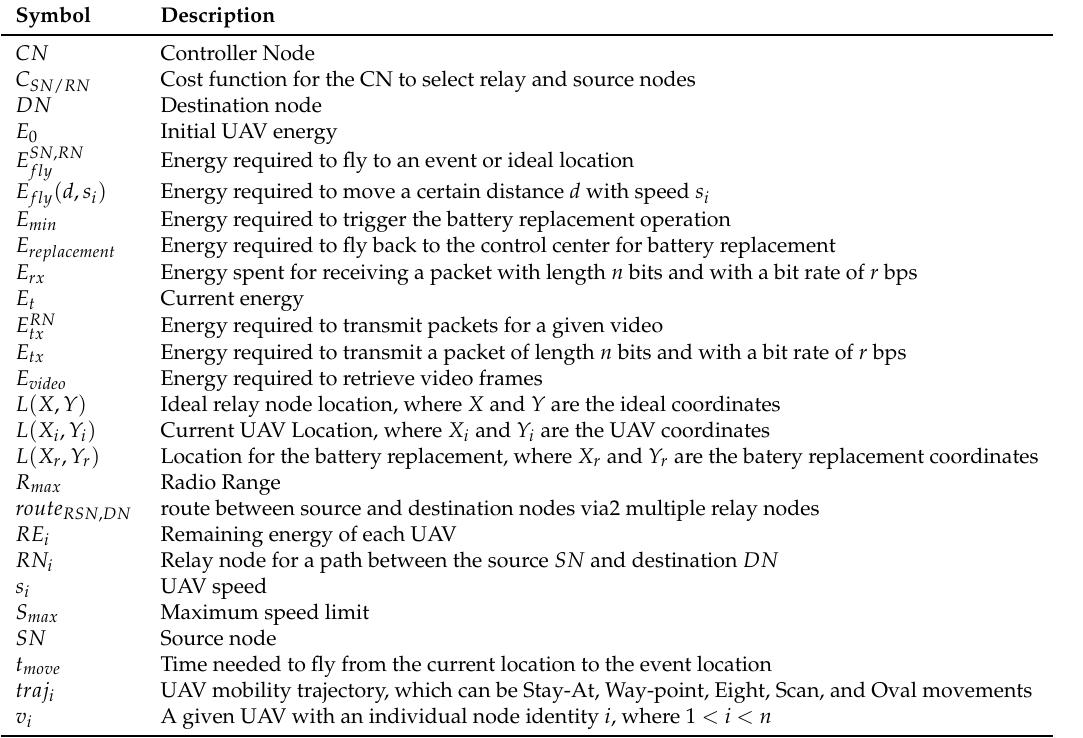
Table 1. List of main symbol used for VOEI